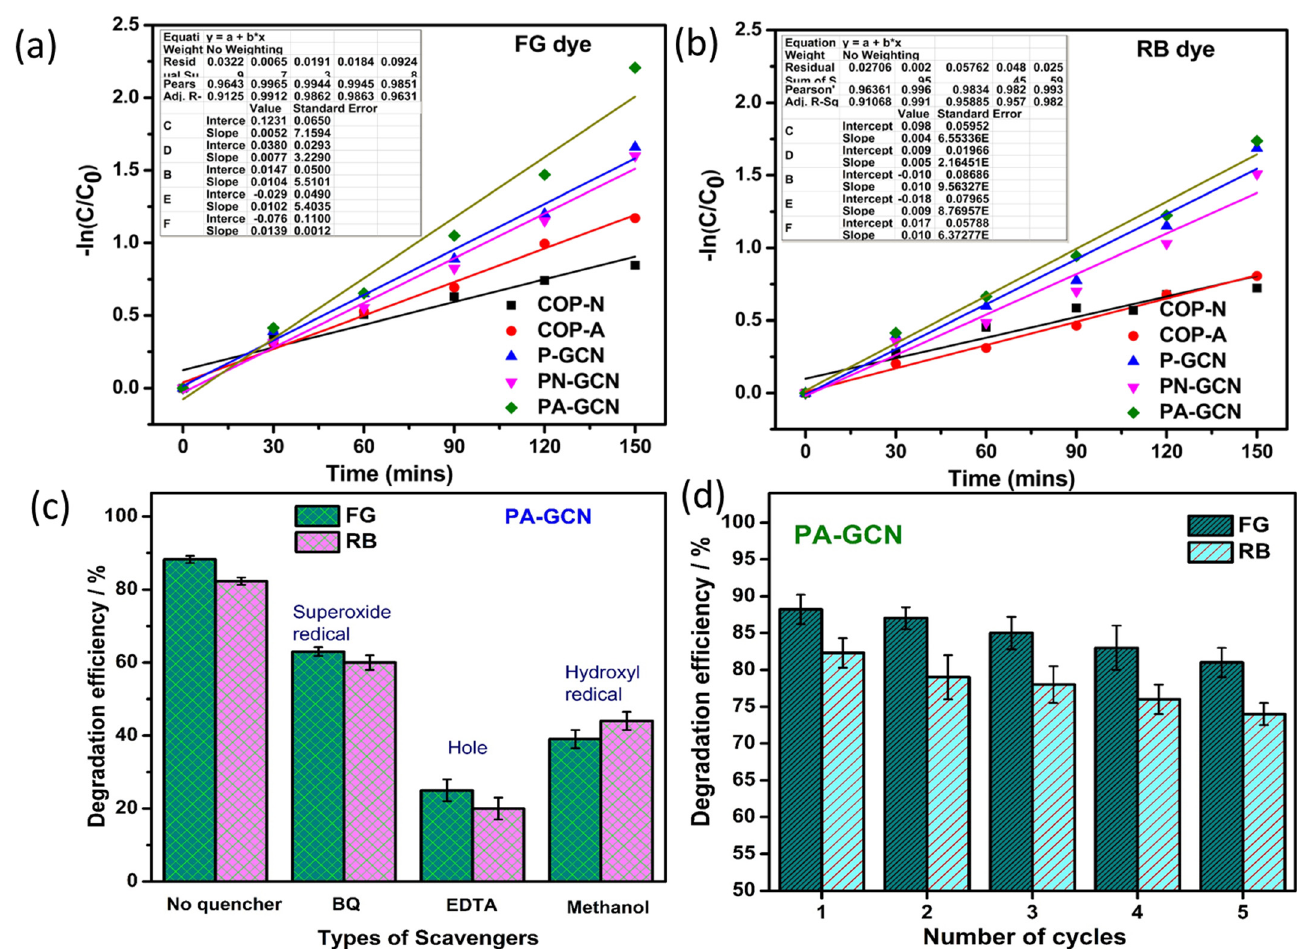
Figure 12. Degradation kinetic studies of ( a ) FG and ( b ) RB dye, ( c ) scavenger study, and ( d ) reusability of PA-GCN catalyst. Table 1. Degradation parameters of COP-N, COP-A, P-GCN, PN-GCN, and PA-GCN against FG and RB dye solution.